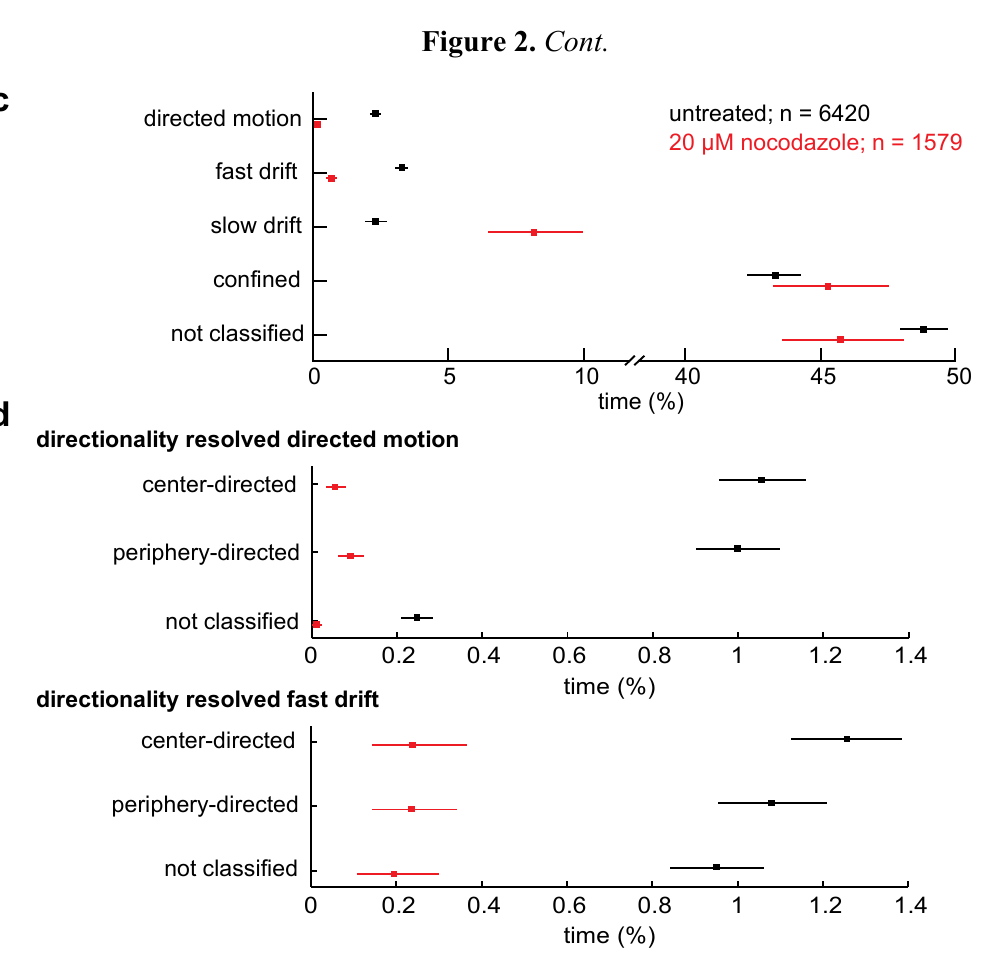
Figure 3. Representative examples for directed motions (DM) and fast drifts (FD). HeLa cells infected with HAdV2-atto565 were imaged and a particle tracker was used to obtain single virus trajectories. Trajectories were segmented and short stretches of a directed motion (DM, red) and a fast drift (FD, magenta) are shown. Scale bar represents 160